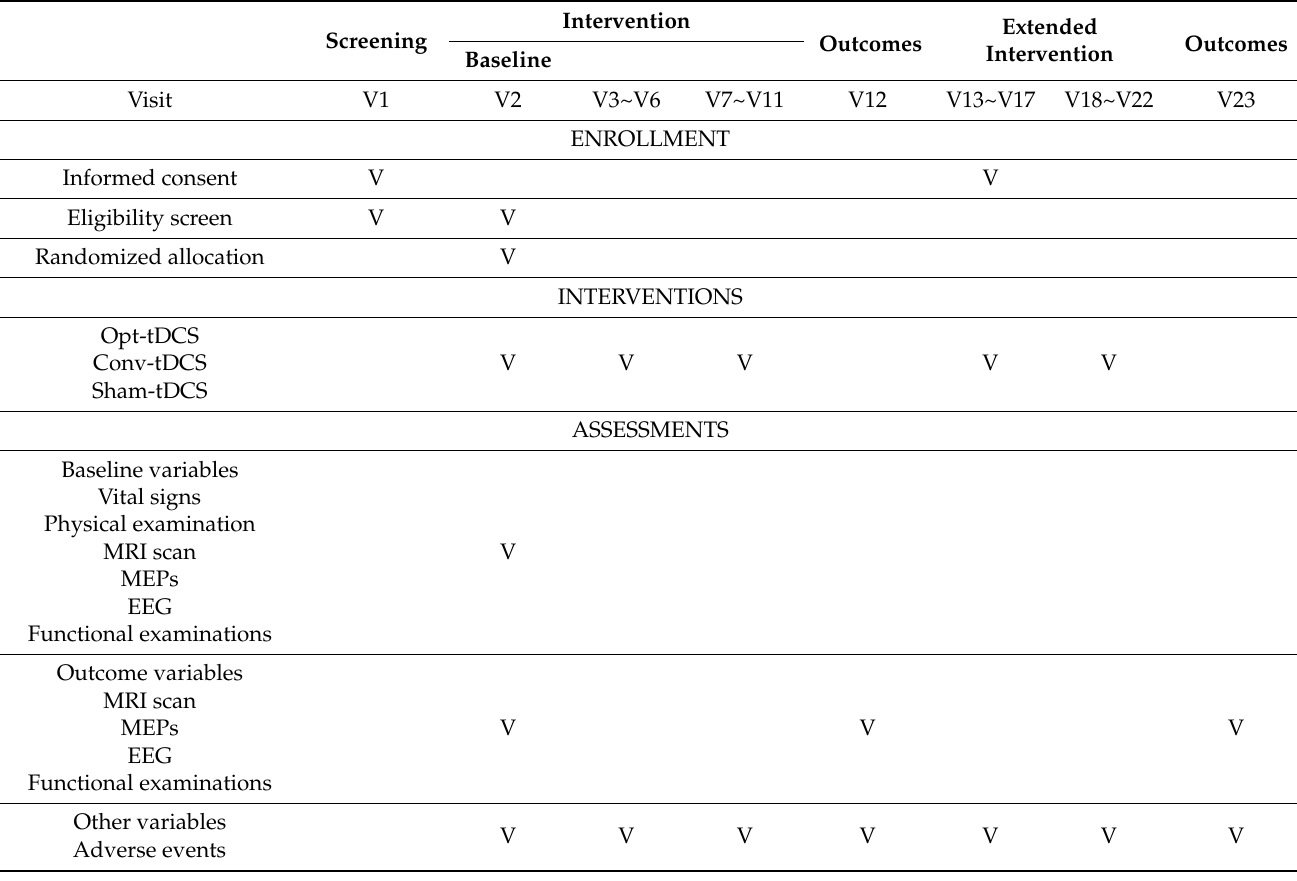
Extended Outcomes Outcomes Intervention